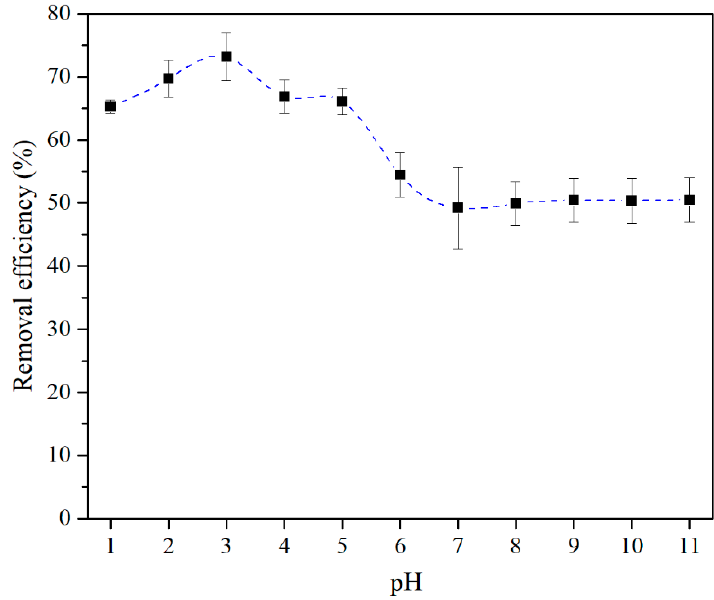
Figure 6. Effect of pH on As(III) adsorption by CTO nanoparticles. Figure 6. E ff ect of pH on As(III) adsorption by CTO